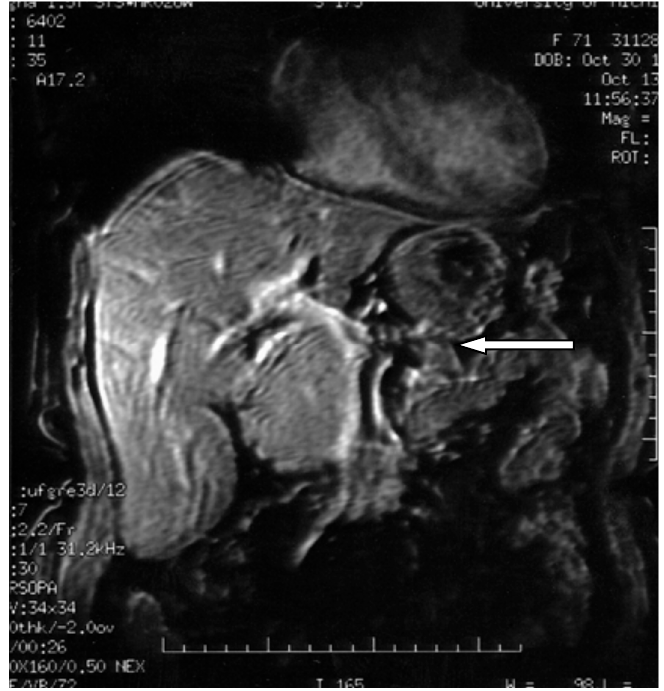
Figure 7. 3D axial magnetic resonance imaging showing pancreatic polypeptide-producing tumors in the head of the pancreas (arrow) [18]. Diseases 2018 , 6 , 8